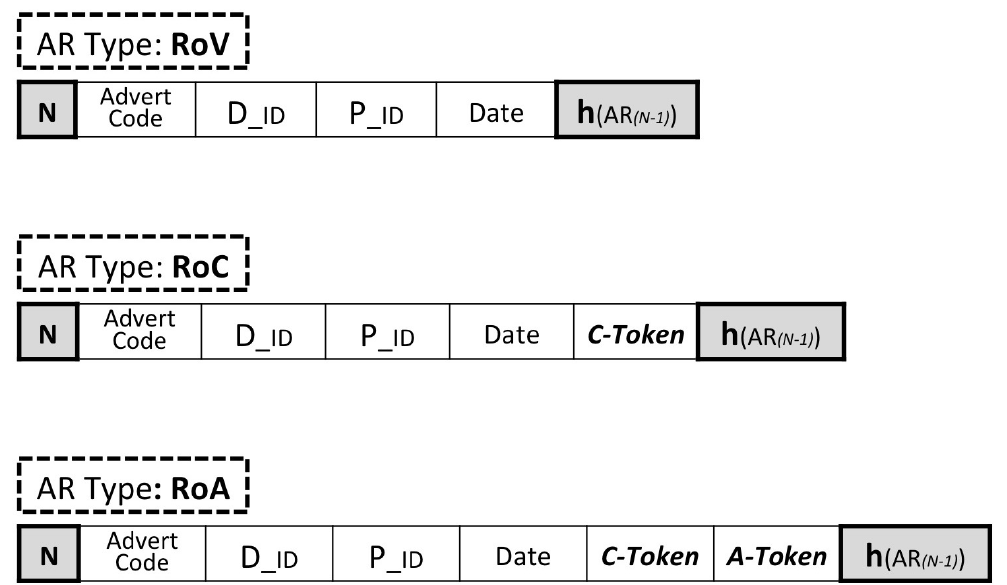
Figure 3. Supported types of Ad-Reports and their